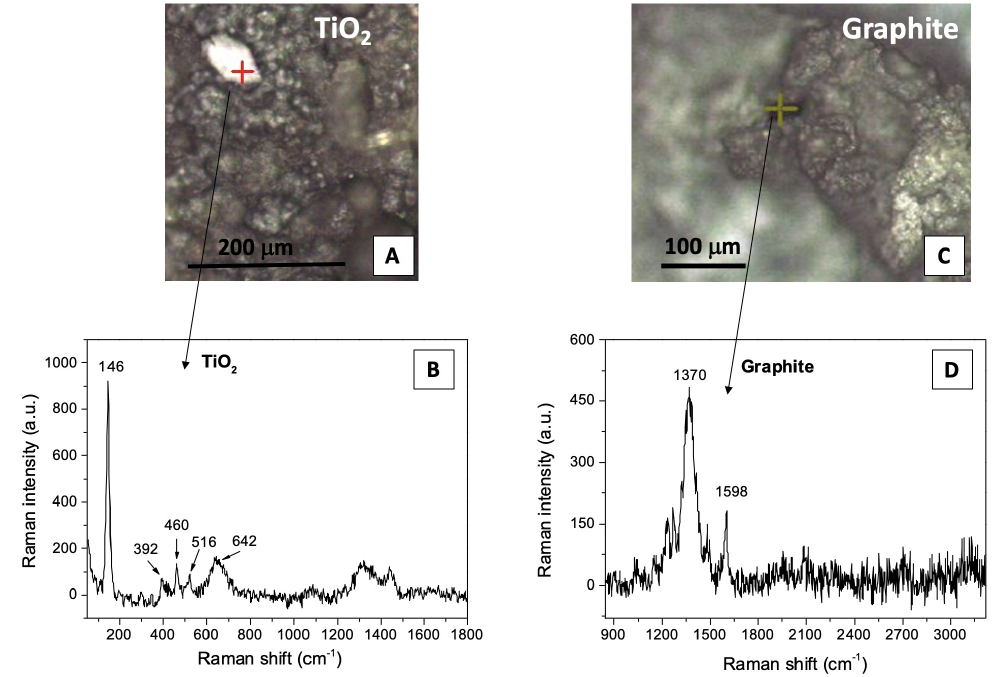
Figure 5. ( A , B ) Optical images of a TiO 2 cluster and a graphite scrap, respectively, detected in the Dobrota sample only, and ( C , D ) corresponding Raman